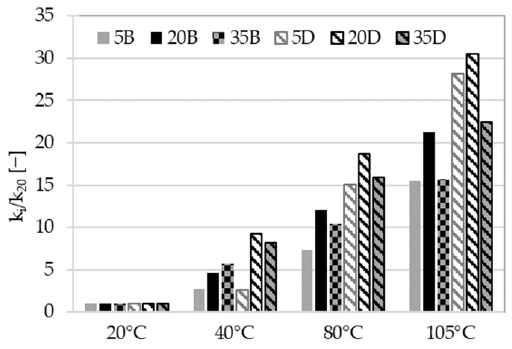
Figure 3. Values of k i /k 20 ratios for temperatures of preconditioning.